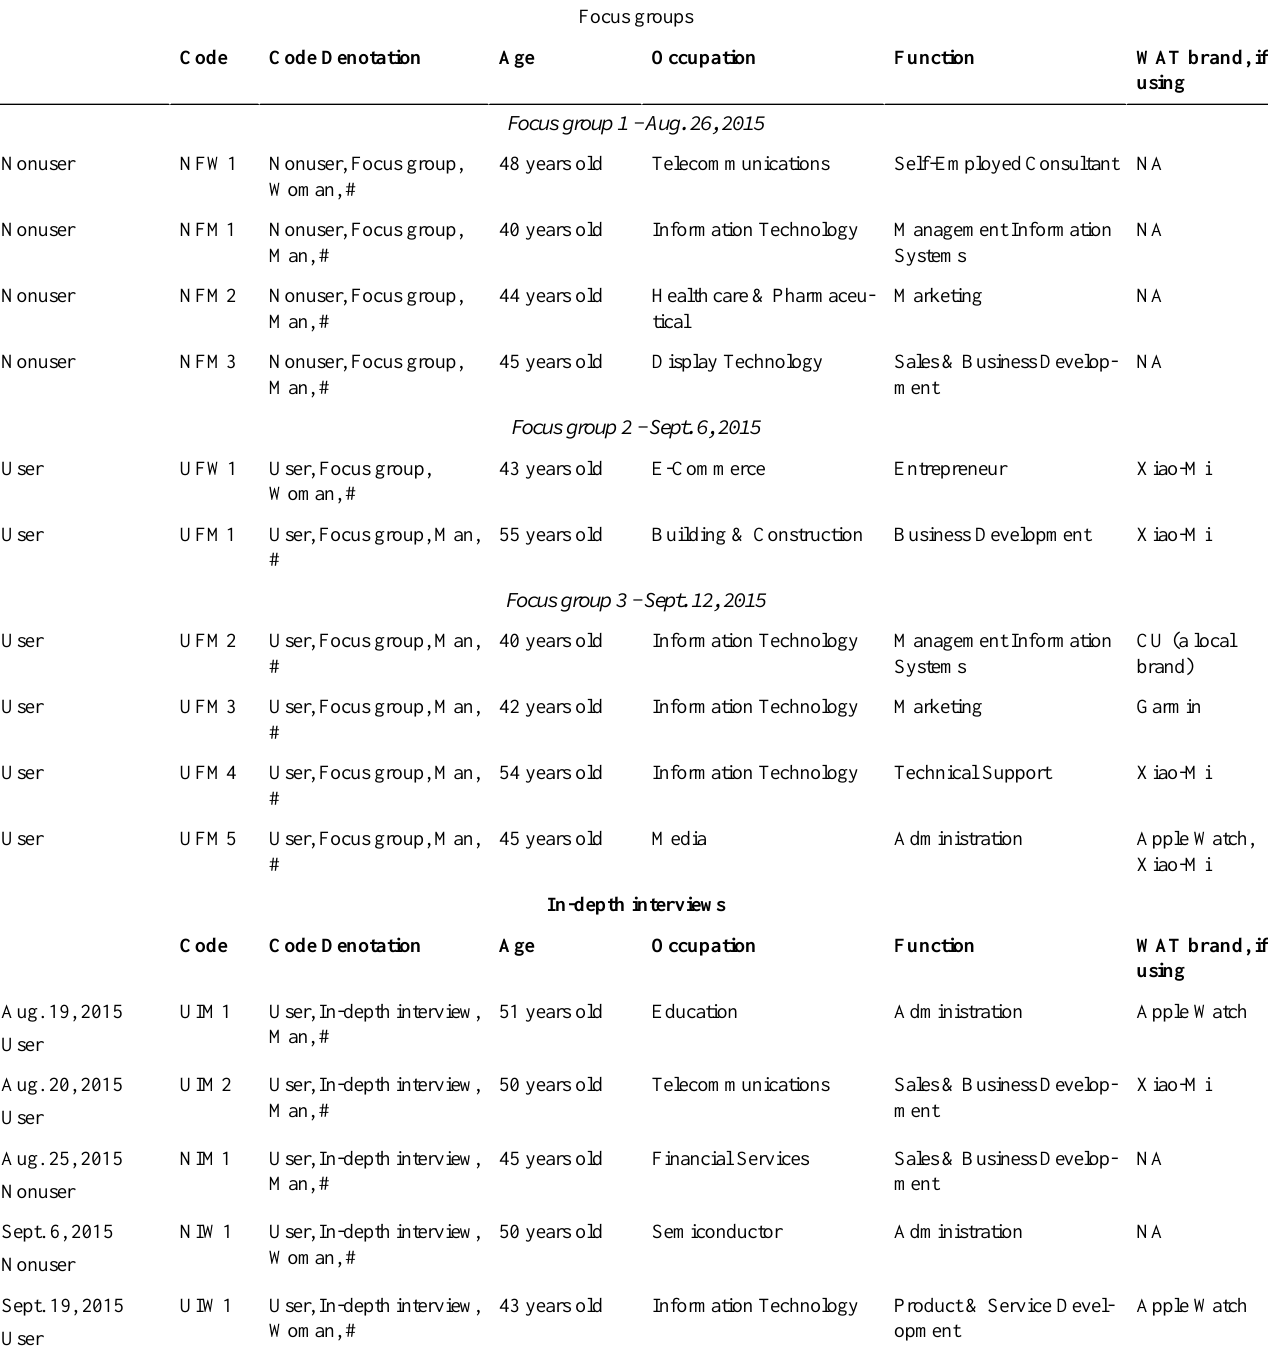
Table 1. Data pertaining to focus groups and in-depth